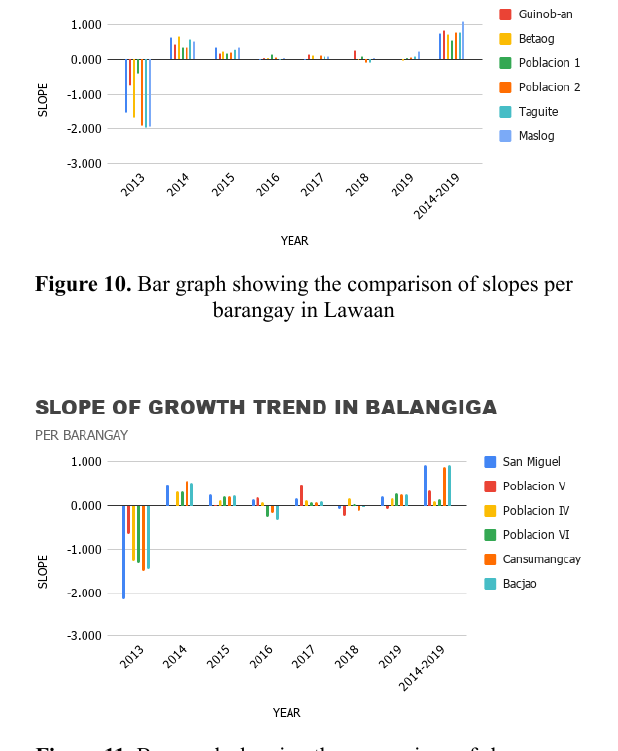
Figure 9. NDVI time series charts for each coastal barangay of Balangiga (a) San Miguel, (b) Poblacion V, (c) Poblacion VI, (d) Cansumangcay, (e) Bacjao